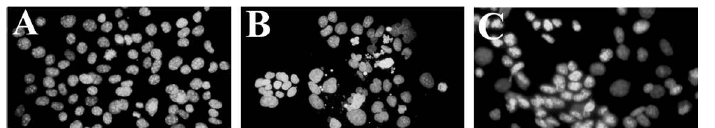
FIG. 2. Ceramide had no effect on apoptosis in Mode-K cells (C), although cells did undergo apoptosis when exposed to ultraviolet rays (B) as compared with a time control (A).